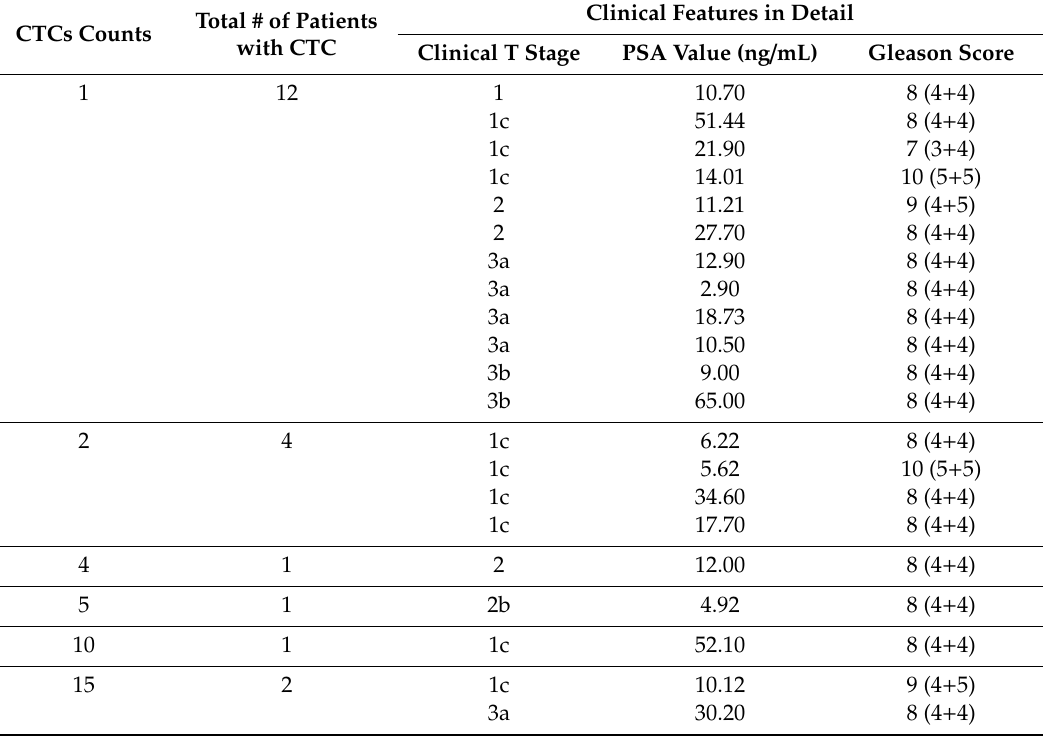
cells captured on the DC01 as positive control for CTC staining panel by immunofluorescence staining (DNA (blue) and pan-CK (green)); lower panel: leukocytes attached to the DC01 served as negative controls for the CTC staining panel by immunofluorescence staining (DNA (blue) and CD45 (red)). Scale bar: 20 µ m. ( c ) Scanning electron microscope image showing the surface of DC01 and blood components, including unspecific binding of leucocytes onto DC01. Scale bar (from left to right): 90 µ m, 30 µ m, and 9 µ m. ( d ) Three CTC clusters on the DC01 detected from two patients; CTC clusters were found as a cluster of CTCs being positive for nucleic staining and pan-CK, and negative for CD45 by immunofluorescence staining (DNA (blue) and pan-CK (green)). All CTCs were negative for PSA, so this channel is not shown. Exposure time for each channel: nucleus DNA, 800~1000 ms; pan-CK, 3000 ms; CD45, 6000 ms. Scale bar: 20 µ m. Table 3. Clinical features of circulating tumor cell (CTC)-positive patients grouped by CTC count detected by DC01 at first sampling time point before radiotherapy. Clinical Features in Detail Total # of Patients CTCs Counts with CTC Clinical T Stage PSA Value (ng / mL) Gleason